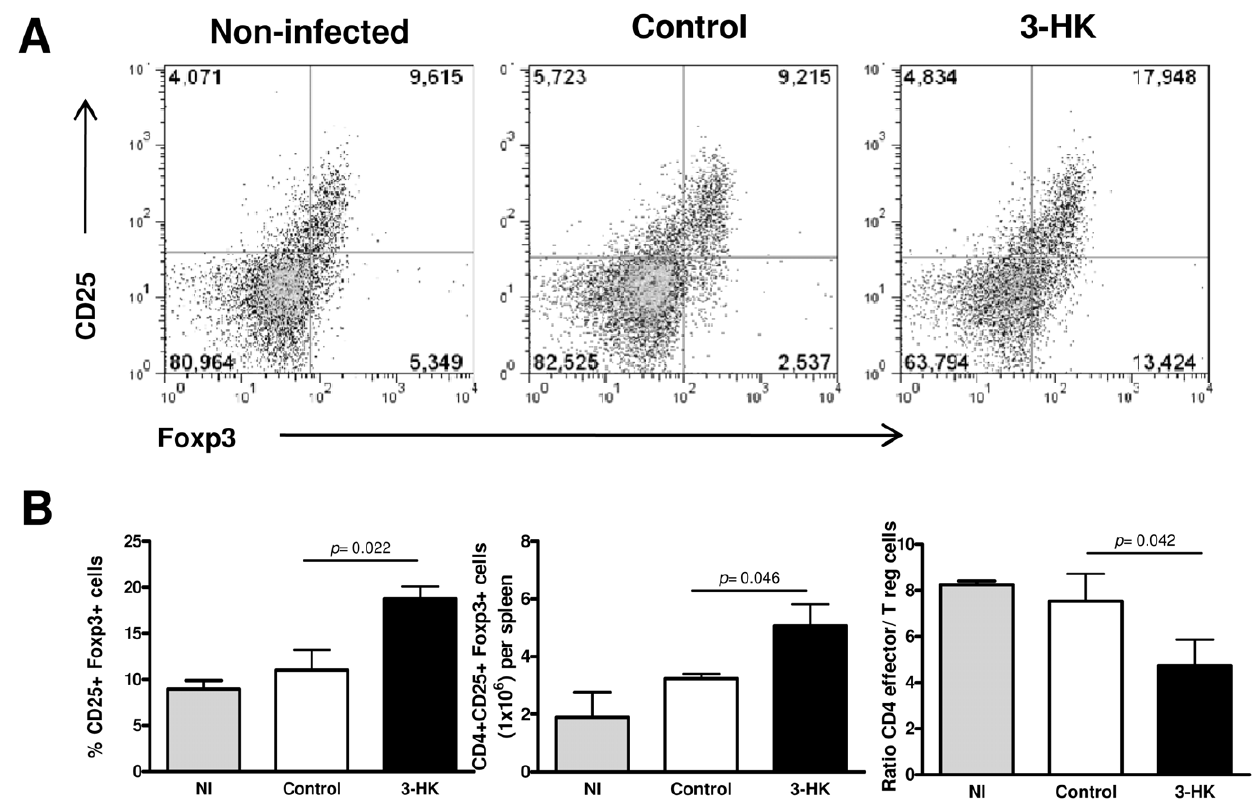
Figure 5. 3-HK treatment promotes Treg cell development. Splenocytes from 3-HK (n=4) or control (n=4) mice isolated at 30 dpi were analyzed ex viv o by flow cytometry for the surface expression of CD4 and CD25 and the intracellular expression of Foxp3. Samples were collected using a FACScanto II flow cytometer and data were analyzed using FlowJo (Tree Star) software. (A) Plots from a representative animal with CD25 and Foxp3 expression on the CD4 + gated population are shown. The numbers represent the percentages of CD4 + cells expressing CD25 + and Foxp3 + in the live spleen population. (B) Percentage of CD4 + cells expressing CD25 + and Foxp3 + (left panel), absolute number of CD4 + CD25 + Foxp3 + cells per spleen (middle panel) and the relative ratio of effector T cells (CD4 + CD25-) per Treg cells (CD4 + CD25 + Foxp3 + ) at 30 dpi in NI, 3-HK and control groups. Bars represent the mean values 6 SD from 4 mice/group. These results are from one of three similar experiments, all of which gave similar data.